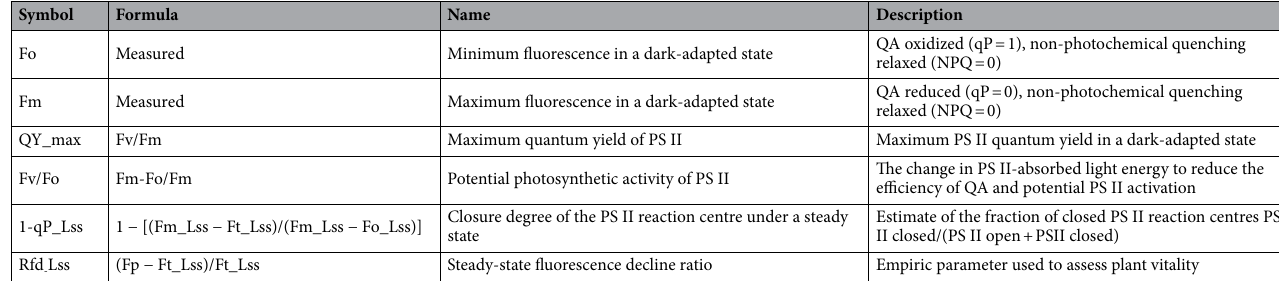
Table 2. Detailed information on the chlorophyll fluorescence